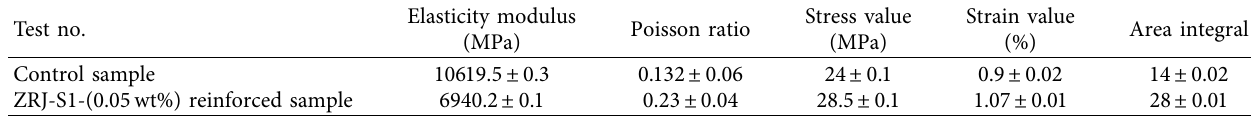
Table 7: Mechanical parameters of cement-based material under stress–strain loading.